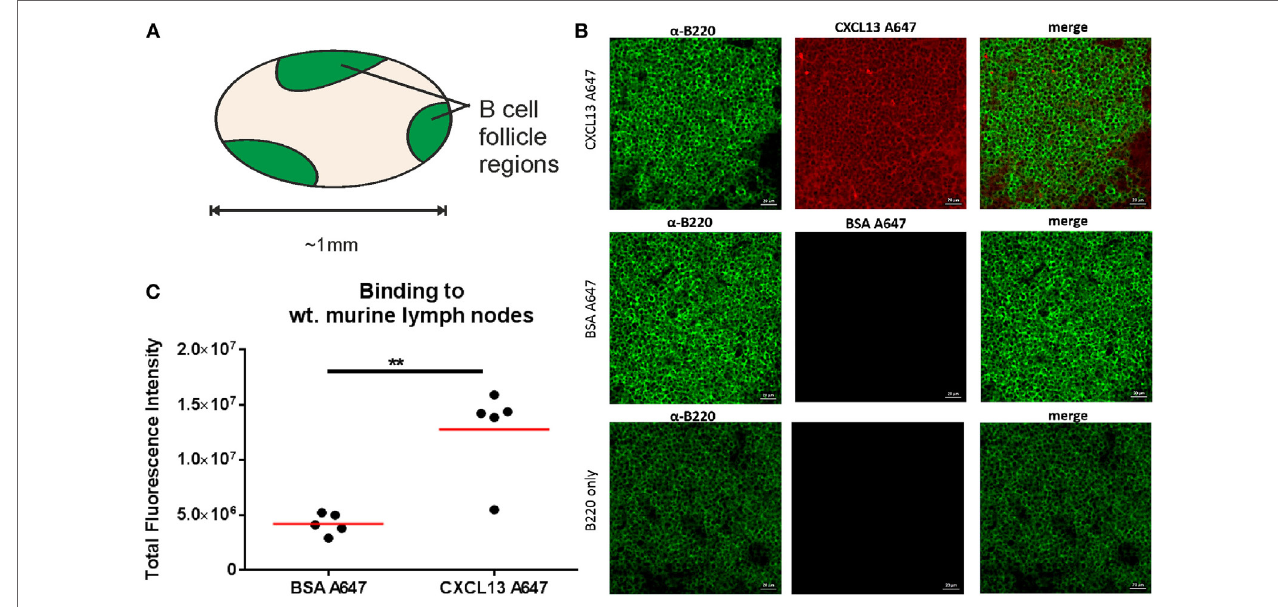
FigUre 6 | Confocal microscopy quantification of CXCL13-AF647 binding to lymph node follicles. (a) Schematic diagram of approximate locations of B-cell follicles in a wild-type murine lymph node. (B) Exemplar confocal microscopy images of CXCL13-AF647 and BSA-AF647 binding to lymph node tissue follicles (B220 + regions of lymph node tissue sections), and control with only B220 staining. (c) Quantification of the total fluorescent intensity for a fixed size imaging plane within a lymph node follicle. Each data point represents a distinct